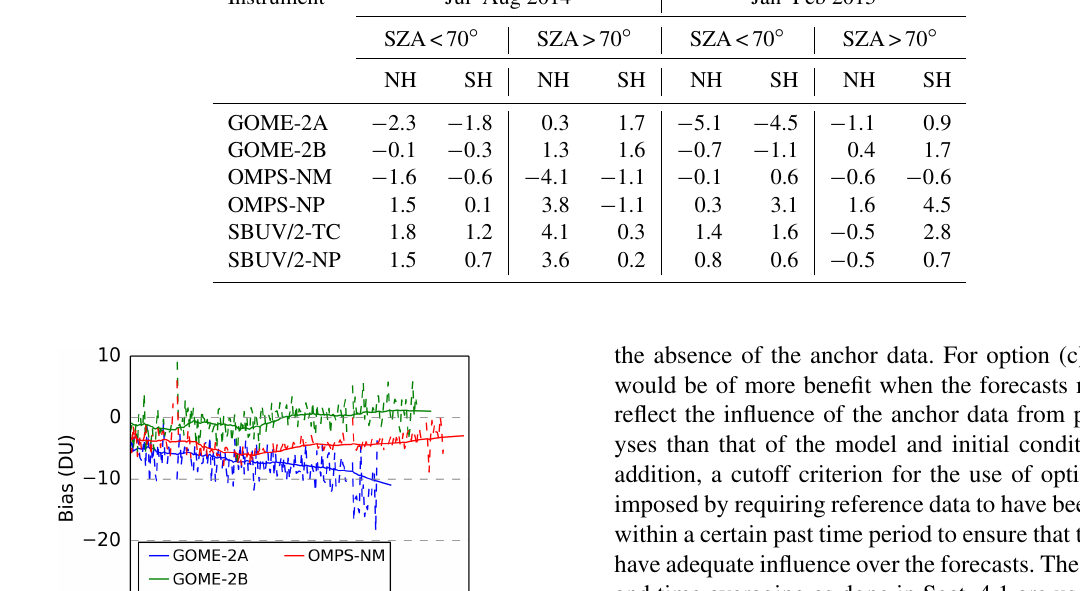
Table 3. Mean differences of the total column ozone (%) between satellite instruments and OMI-TOMS for July–August 2014 and January– February 2015 for the Northern Hemisphere and Southern Hemisphere, for solar zenith angles below and above 70 ◦ . Instrument